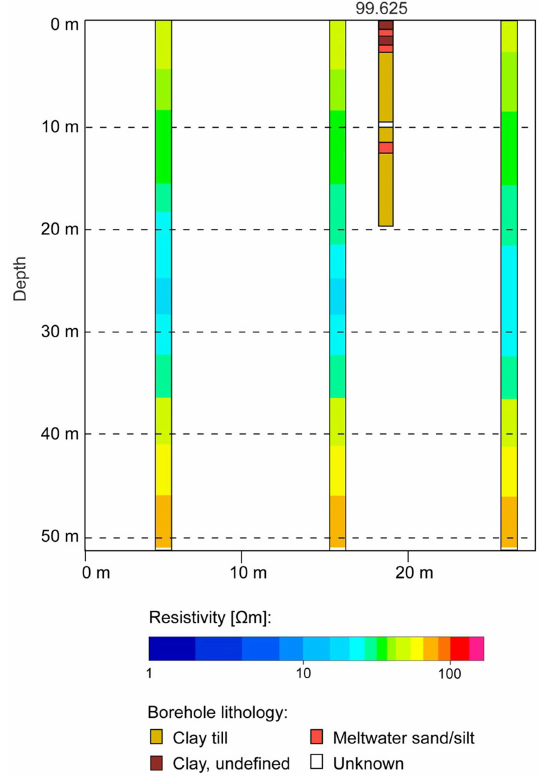
Figure 3. Side-by-side comparison of borehole lithological data and SkyTEM vertical sounding data at borehole number 99.625 (He et al., 2014).